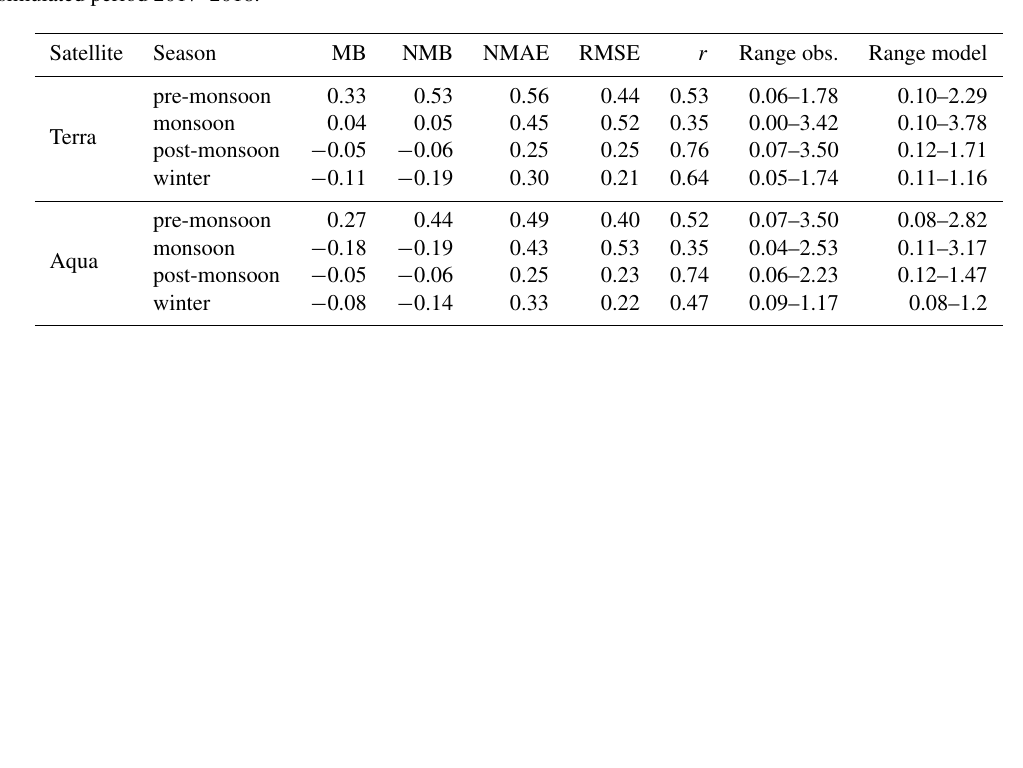
Table B5. Seasonal comparison of modelled total AOD column and satellite AOD observations for the Terra and Aqua instruments over the IGP for the simulated period